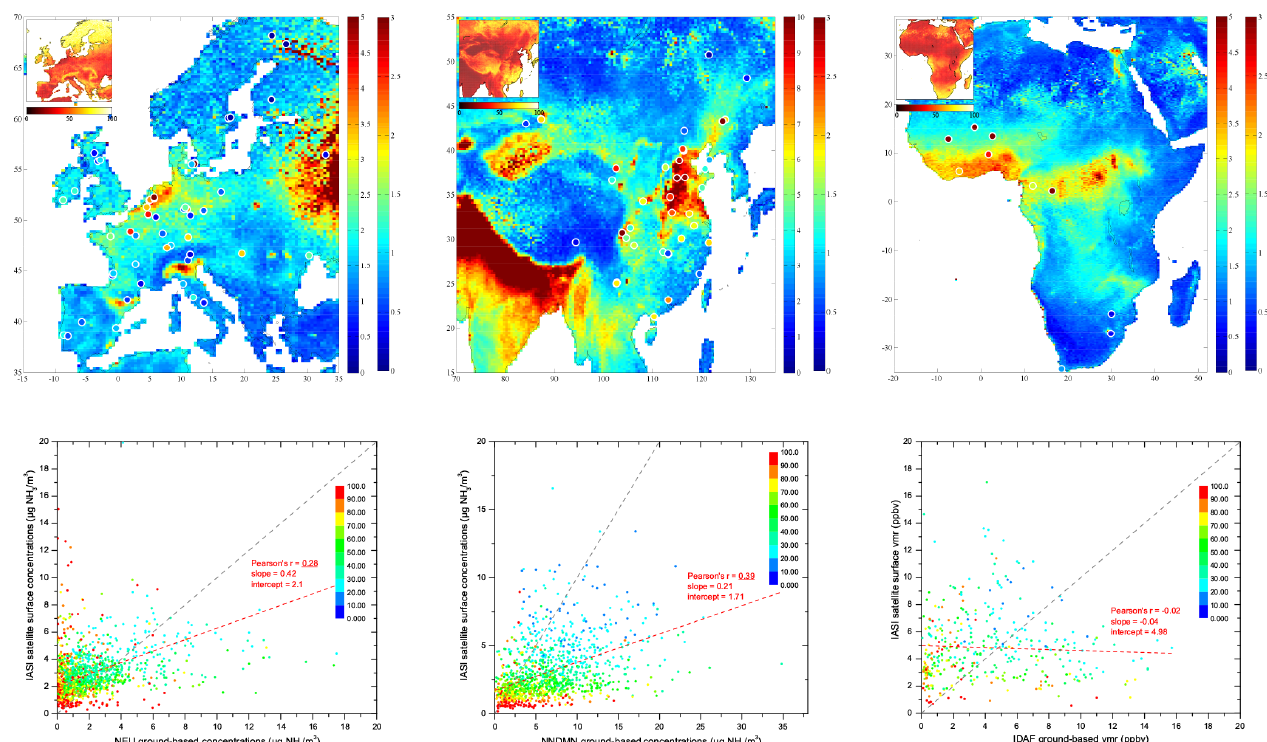
Figure 3. Top: ground-based quantities (left vertical color bar) from NEU (µgm − 3 , left panel), NNDMN (µgm − 3 , middle panel) and IDAF (ppbv, right panel) data sets plotted on top of the NH 3 satellite columns ( × 10 16 moleccm − 2 , right vertical color bar) distribution gridded at 0.25 ◦ lat × 0.5 ◦ long, both averaged for the period covered by the data sets. Stations with less than two-thirds of measurement availability for the period considered have been excluded. The relative error distribution from IASI retrieval is shown as inset (top left, %, horizontal color bar). Columns/errors have been calculated as a mean of all the measurements within a cell, weighted by the relative error following equations described in Van Damme et al. (2014a). Bottom: monthly NEU (left panel), NNDMN (middle panel) ground-based concentrations (µgm − 3 ) and IDAF (right panel) ground-based VMR (ppbv) vs. IASI-retrieved NH 3 surface concentrations (µgm − 3 ) or VMR (ppbv). The color scale corresponds to the IASI retrieval errors (%). Dashed red lines represent the linear regression and gray dashed lines represent the one-to-one line. The Pearson’s r (underlined when significant ( p value below 0.05)), slope and intercept are also indicated in